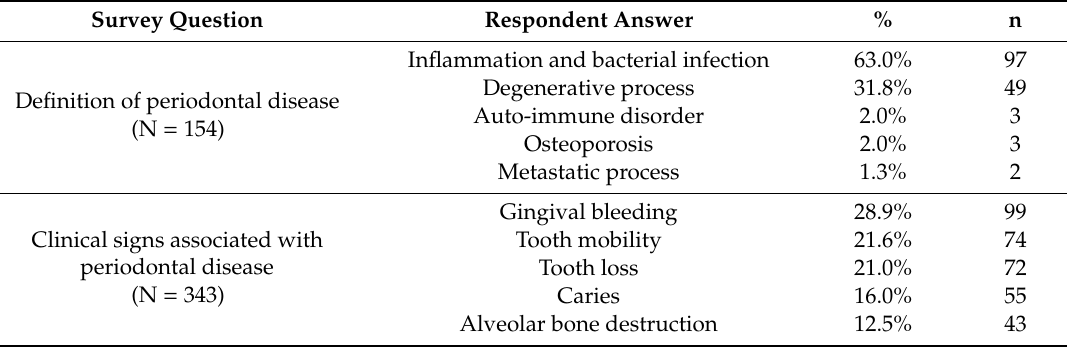
Table 2. Midwives’ knowledge of periodontal disease 1